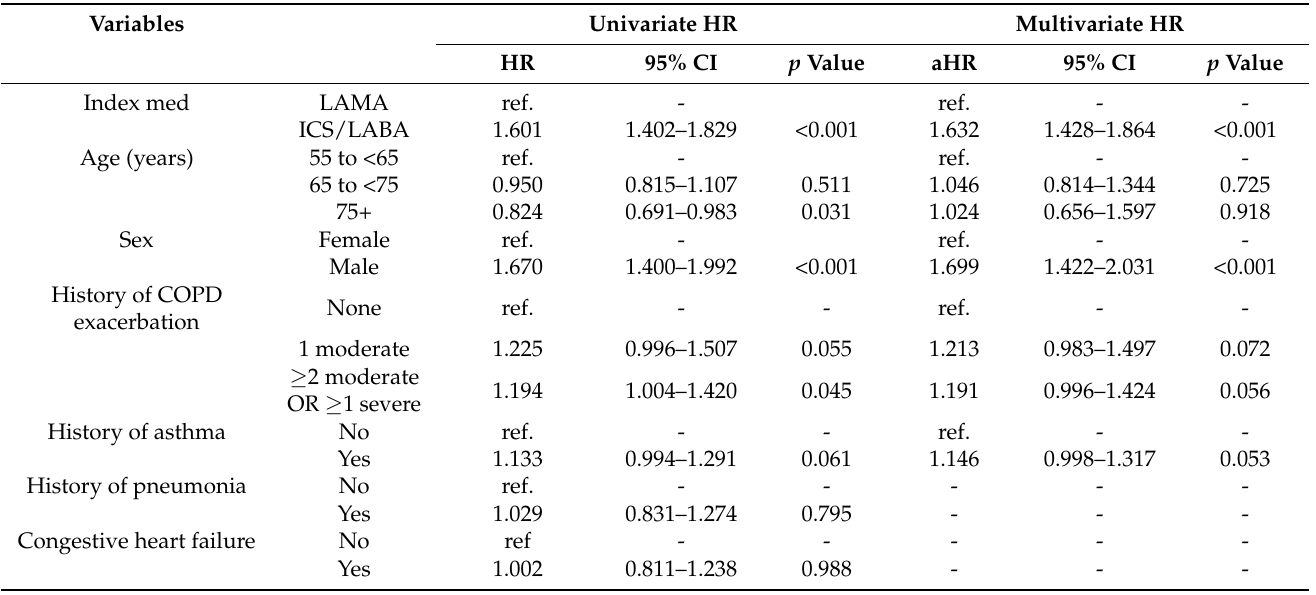
Figure 3. Forest plot comparing triple combination therapy initiation between ICS/LABA and LAMA. Table 3. Risk factors influencing triple combination escalation among the propensity score-matched